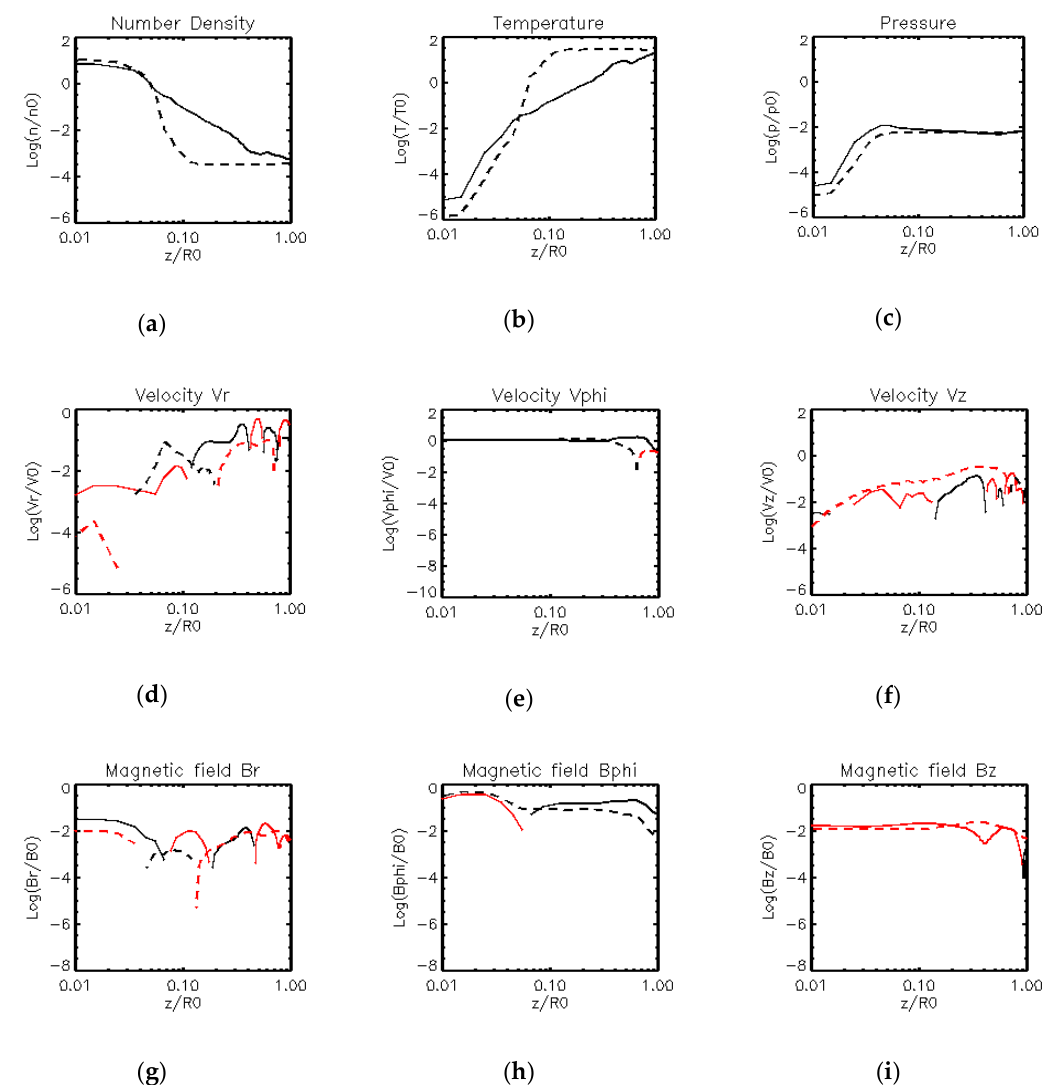
Figure 3. Results of Model 1 and Model 2 at t / t 0 = 30. Dashed lines represent the result of Model 1. Solid Lines represent the results of Model 2. These panels show the vertical distributions of the nine physical quantities averaged between r / r 0 = 0.75 and r / r 0 = 0.85. Black lines indicate positive values. Red lines indicate negative values, that is, mean the absolute values of quantities. ( a ) Number density. ( b ) Temperature. ( c ) Pressure. ( d ) Radial component of velocity. ( e ) Azimuthal component of velocity. ( f ) Vertical component of velocity. ( g ) Radial component of magnetic field. ( h ) Azimuthal component of magnetic field. ( i ) Vertical component of magnetic field.